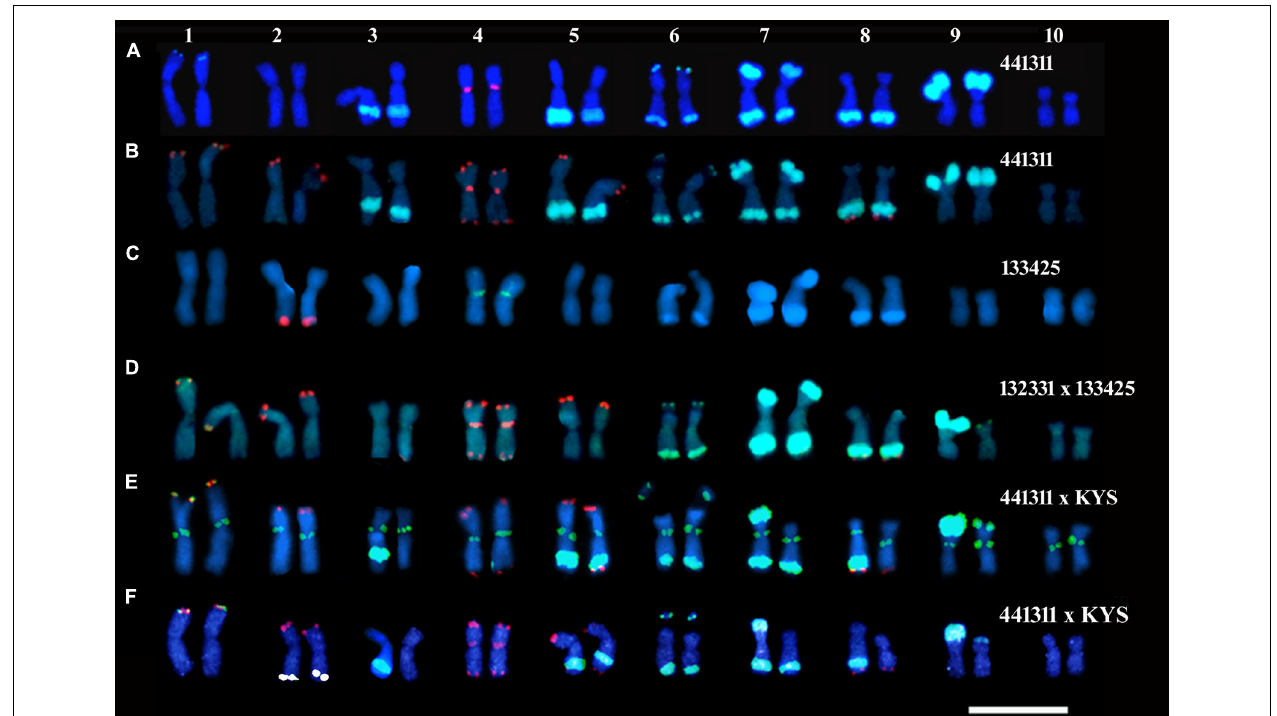
chromosome 9 from the parent 133425, in hybrid 132331 × 133425, has a small 180-bp signal on 9S (D) . Chromosomes 2, 3, 5, 7, 8, and 9 from the 441311 parent (placed on the left) can be recognized in the 441311 × KYS hybrid (E,F) .The chromosomes were counterstained with DAPI. Scale bar = 10 μ